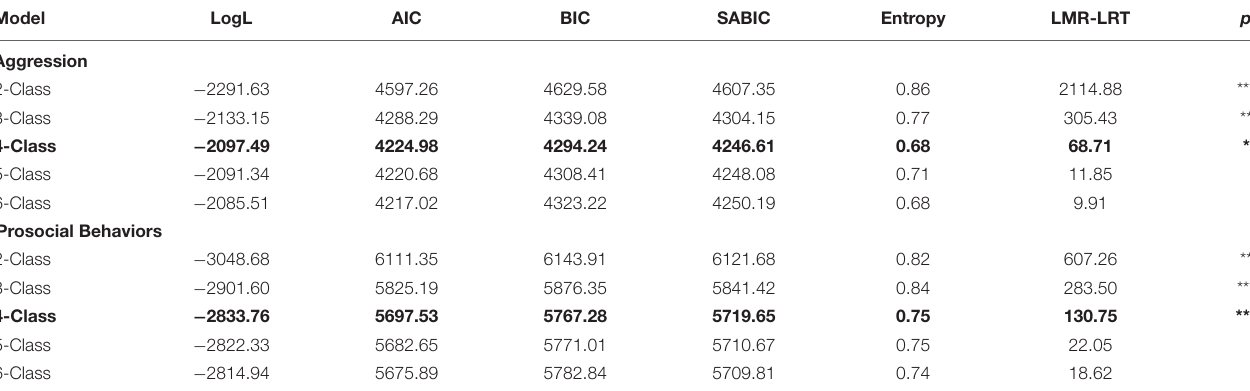
TABLE 2 | Fit indices for models examining trajectories of aggressive and prosocial behaviors. Model LogL AIC BIC SABIC Entropy